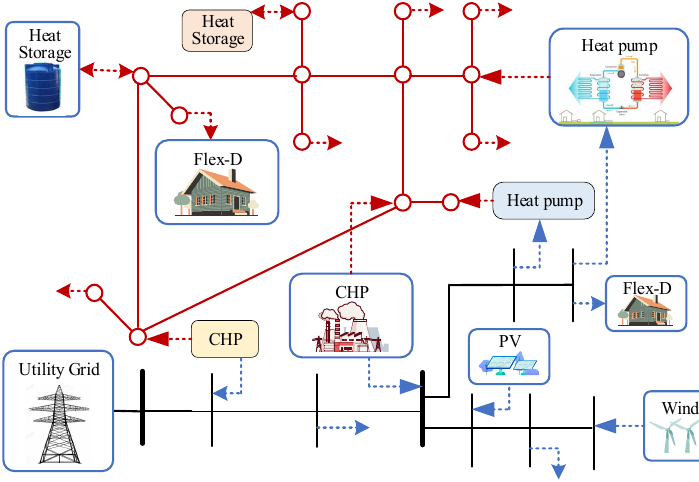
Figure 1. Paradigm of the integrated electricity–heat system.